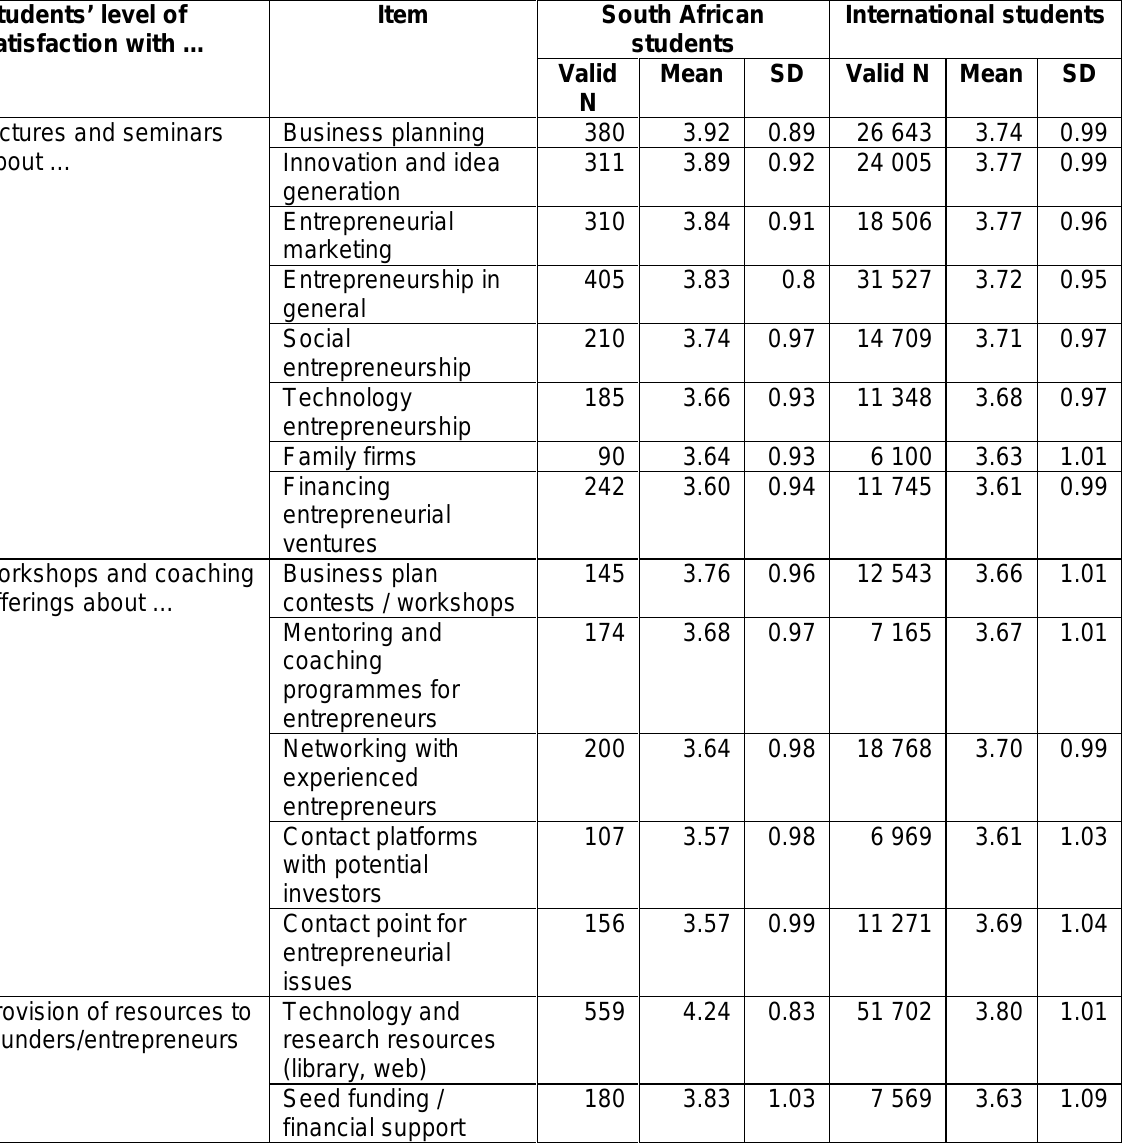
International students Students’ level of